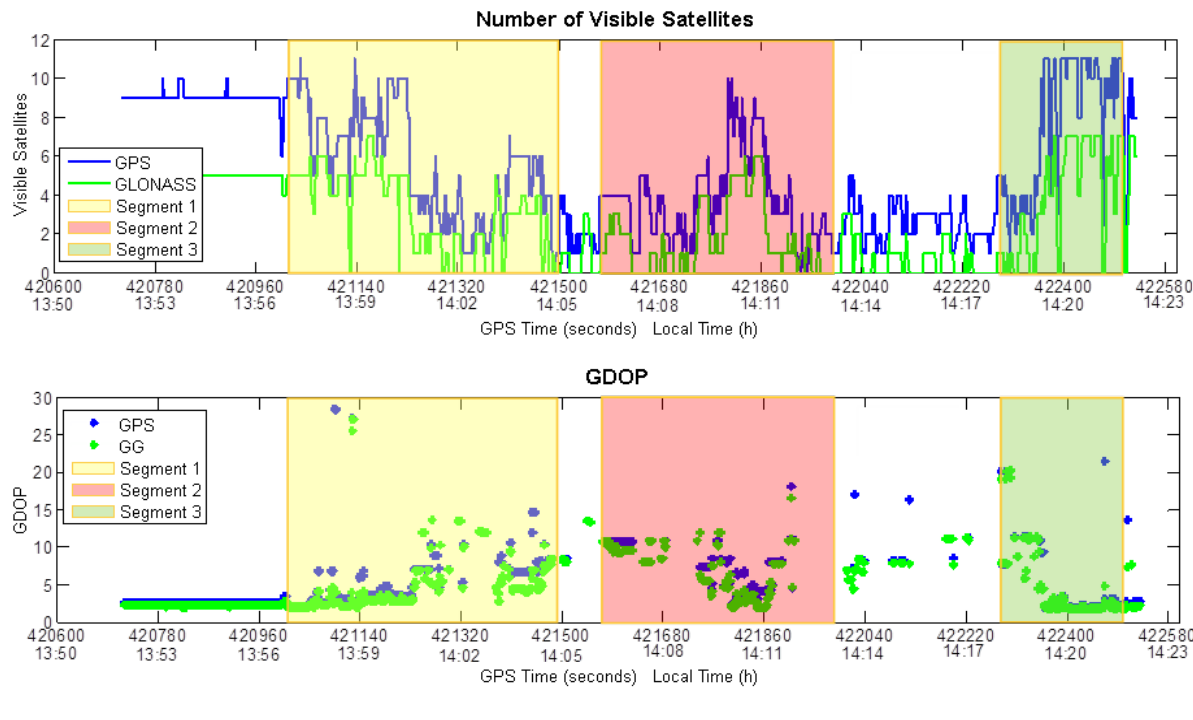
Table 4. GNSS availability and outage